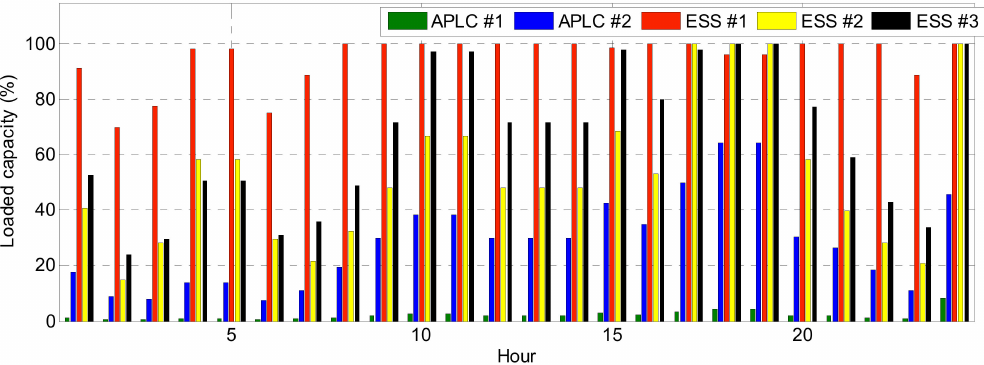
Figure 12. The loaded capacity of AHFs for harmonic filtering in Case